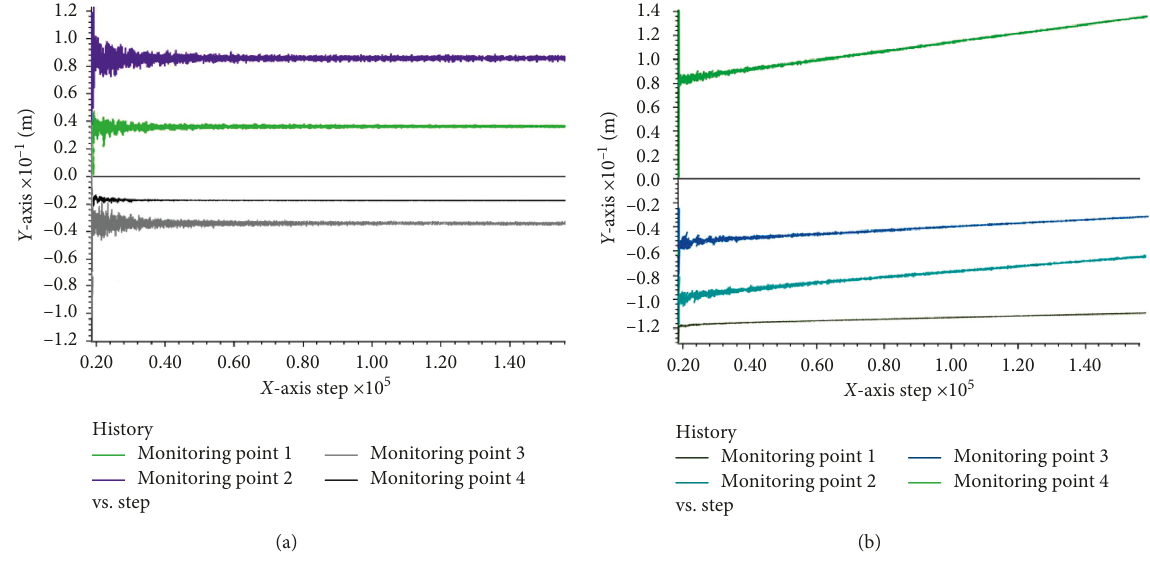
Figure 14: Displacement response diagram for ten dynamic loads. (a) X -direction displacement and (b) Z -direction